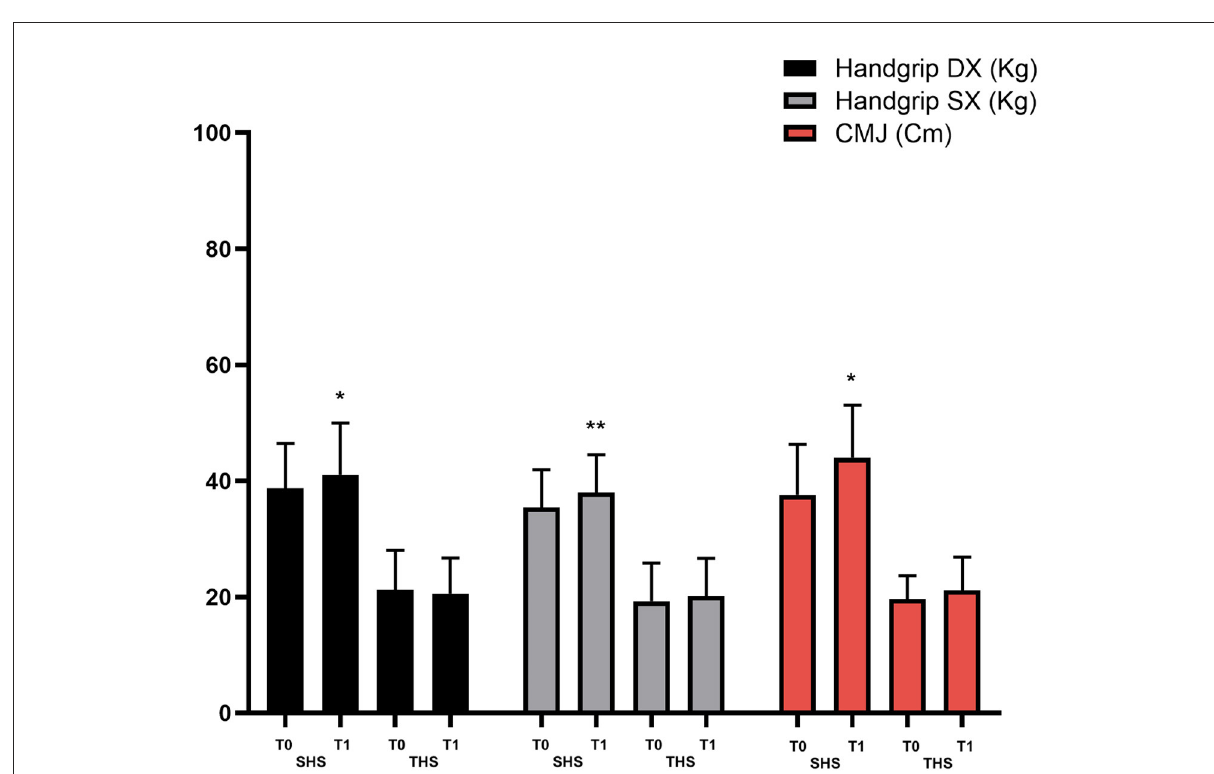
FIGURE3 Analysis between SHS (T0) vs. SHS (T1) and THS (T0) vs. THS (T1). * p < 0.05; ** p < 0.01; *** p < 0.001.